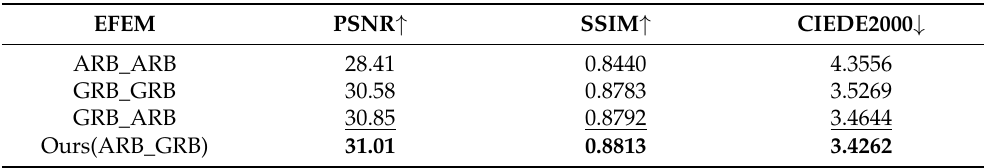
Table 3. Ablution analysis of the structure of EFEM. The bold and underlined text indicates the best and second-best performance, respectively. The ↑ symbol indicates that larger values are better, while ↓ indicates that smaller values are better.